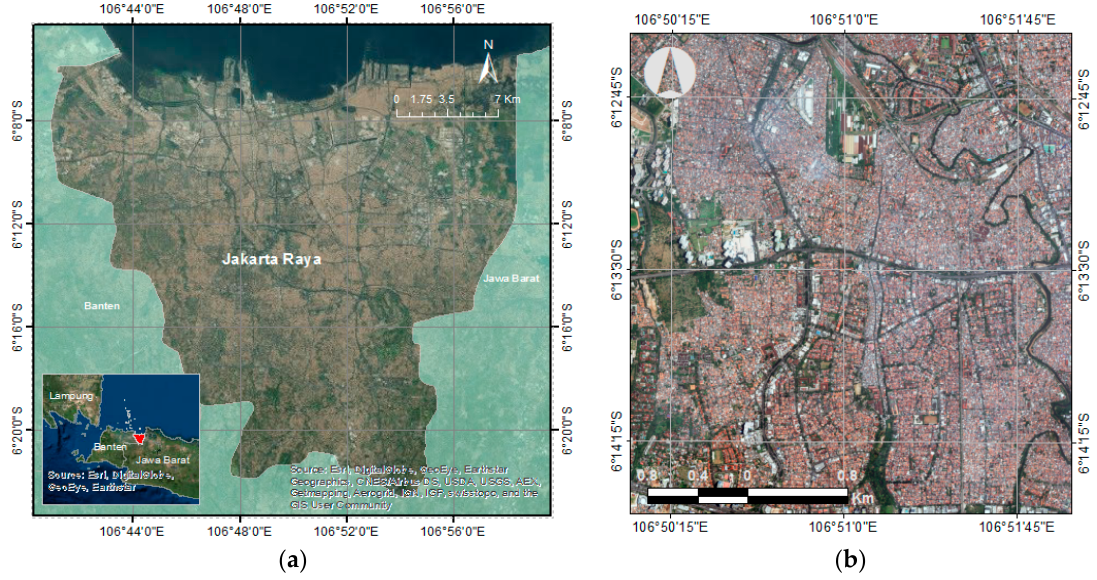
Figure 1. Map of the study area in Jakarta Province (Indonesia) ( a ), surrounded by Banten Province and West Java Province (the metropolitan area includes some parts of these provinces), area boundary source: Openstreet Map (2015) (OpenStreetMap Foundation, Sutton Coldfield, UK); ( b ) selected subset located in Tebet district, Jakarta. Image source: Google Earth (2015) (Mountain View, CA).